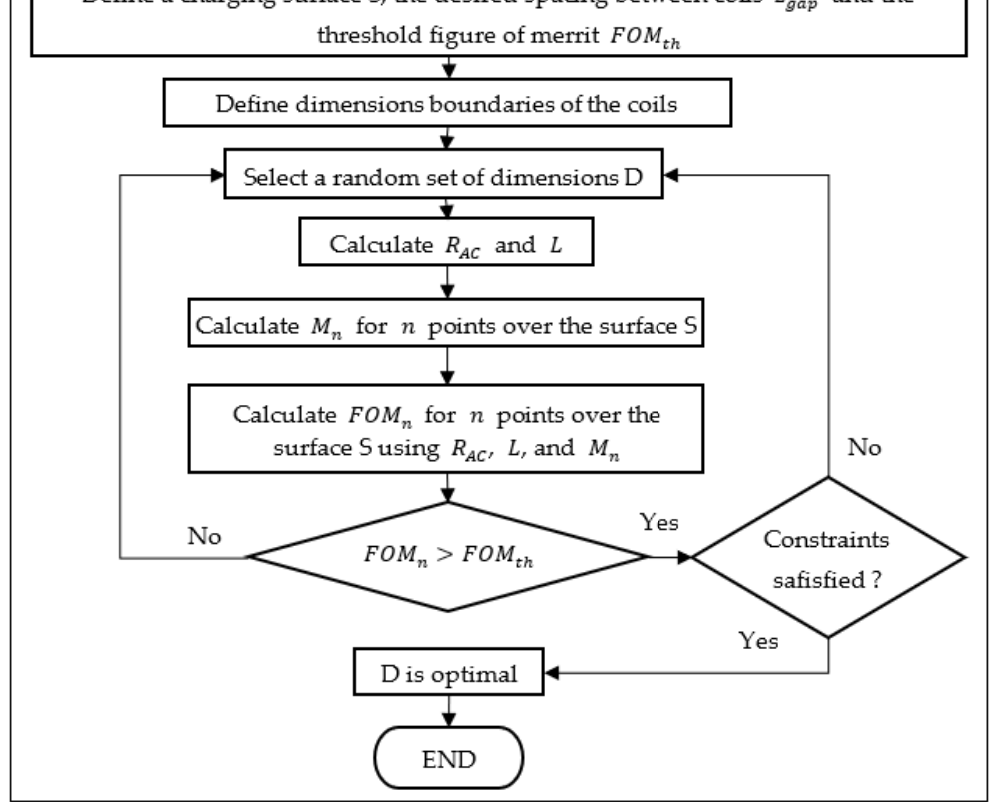
Figure 9. Flowchart of the newly proposed optimization procedure.